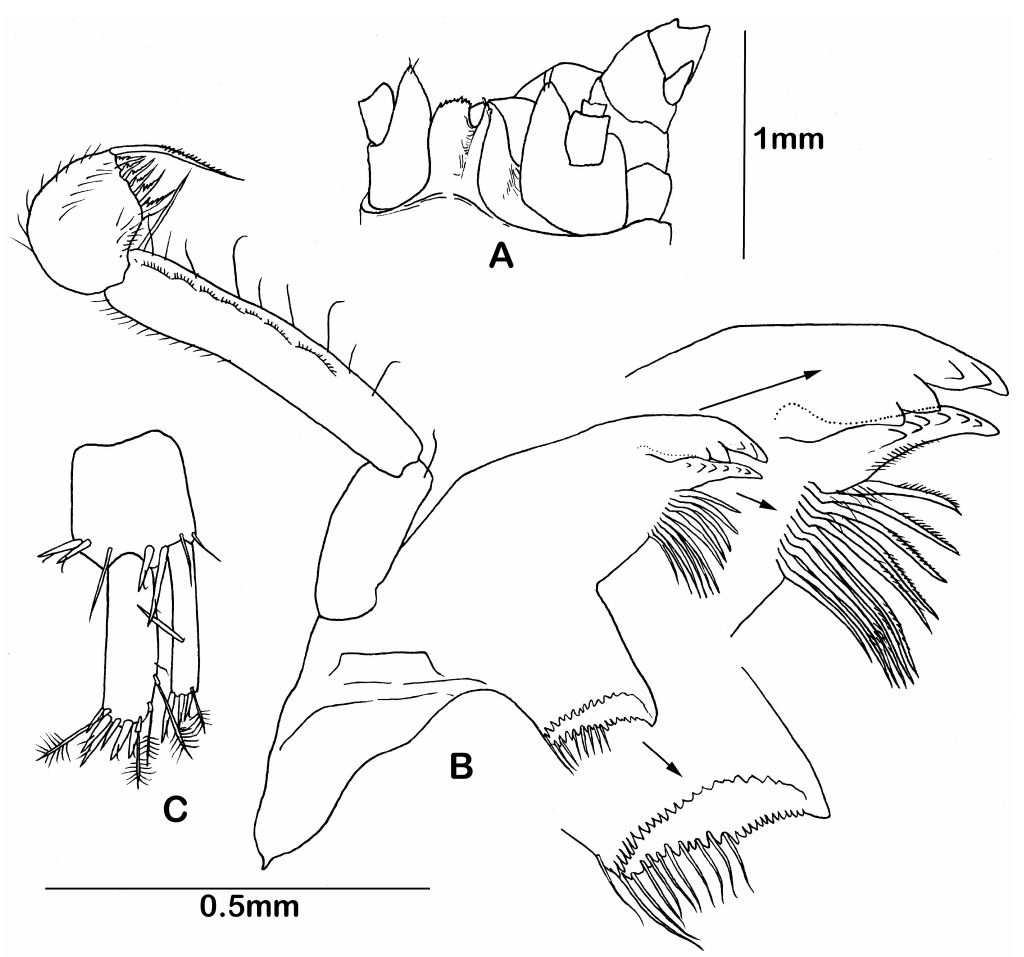
Figure 12. Eurycope dahli Svavarsson, 1987. Male (ZMH K-45598): ( A ) cephalon with rostrum antennae I and antenna II; male (ZMH K-45609): ( B ) left mandible (incisor and molar process enlarged); ( C )